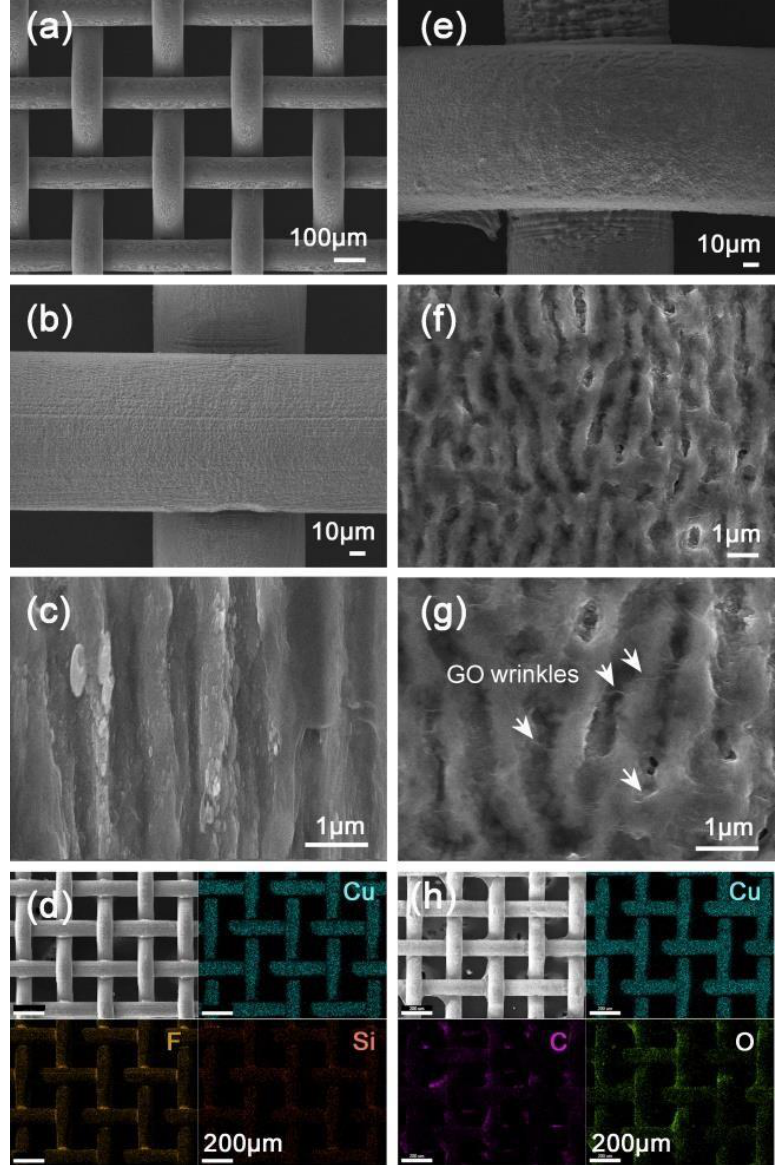
Figure 7. ( a , b ) SEM image of FS laser-structured Janus wire mesh. ( c ) Laser-structured fluorosilane-modified mesh (580 mW, 7.39 × 106 mJ/cm 2 ) at different magnifications. LISR with a period of 900 nm at fluorosilane-modified mesh. ( d ) Elemental map of fluorosilane-modified mesh showing the presence of fluorine and silicon. ( e , f ) Laser-structured GO-modified mesh (100 mW, 12.74 × 105 mJ/cm 2 ) at different magnifications. ( g ) LISR covered with GO wrinkles. ( h ) Elemental map of GO-modified mesh showing the high presence of oxygen and carbon [66]. Reproduced with permission from [66] Royal Society of Chemistry 2017.